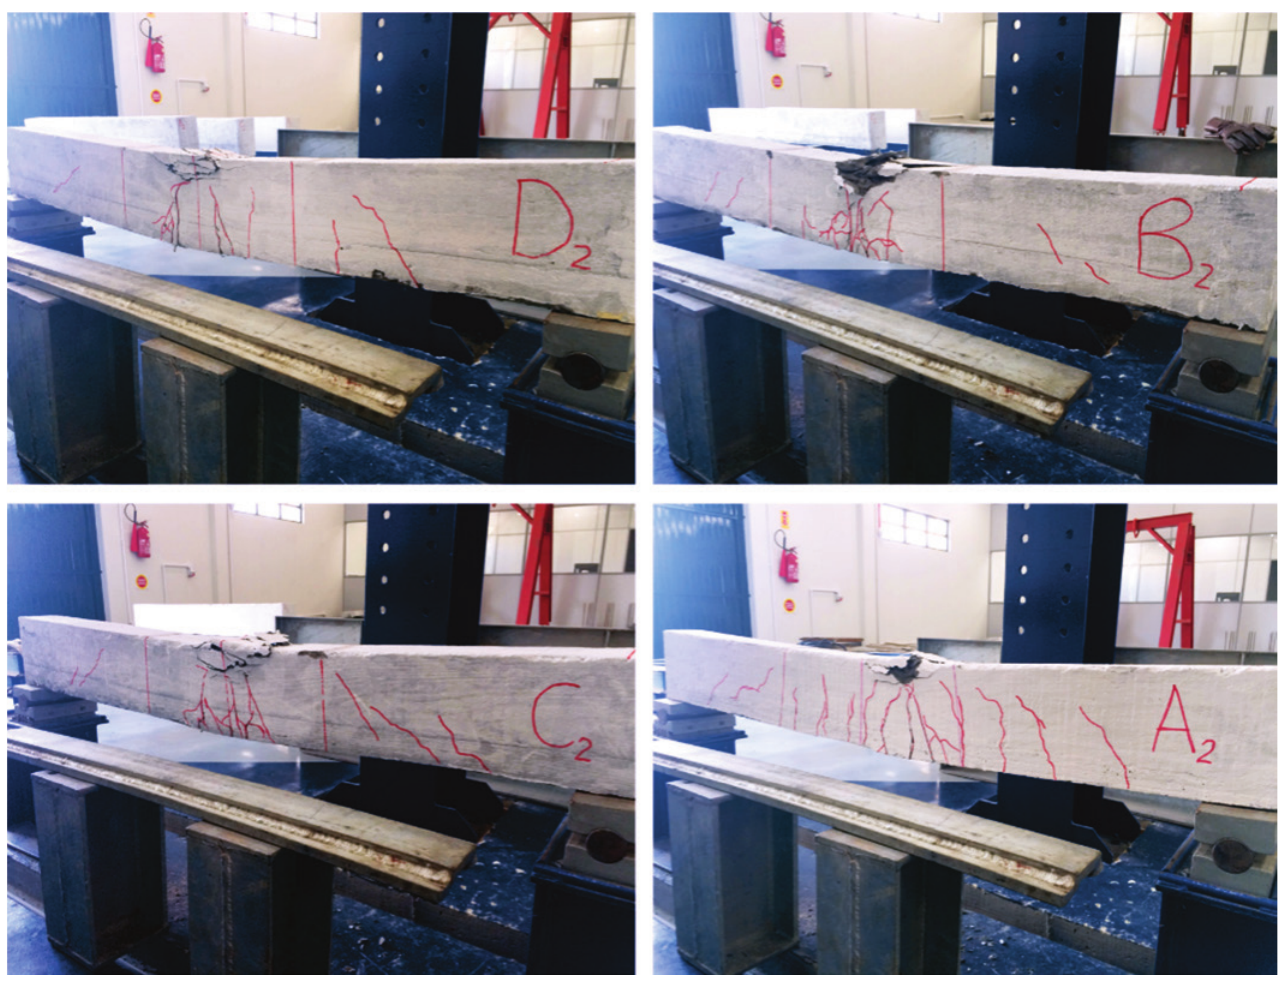
Figure 5 Form of rupture and cracks in beams (12 × 20 × 160